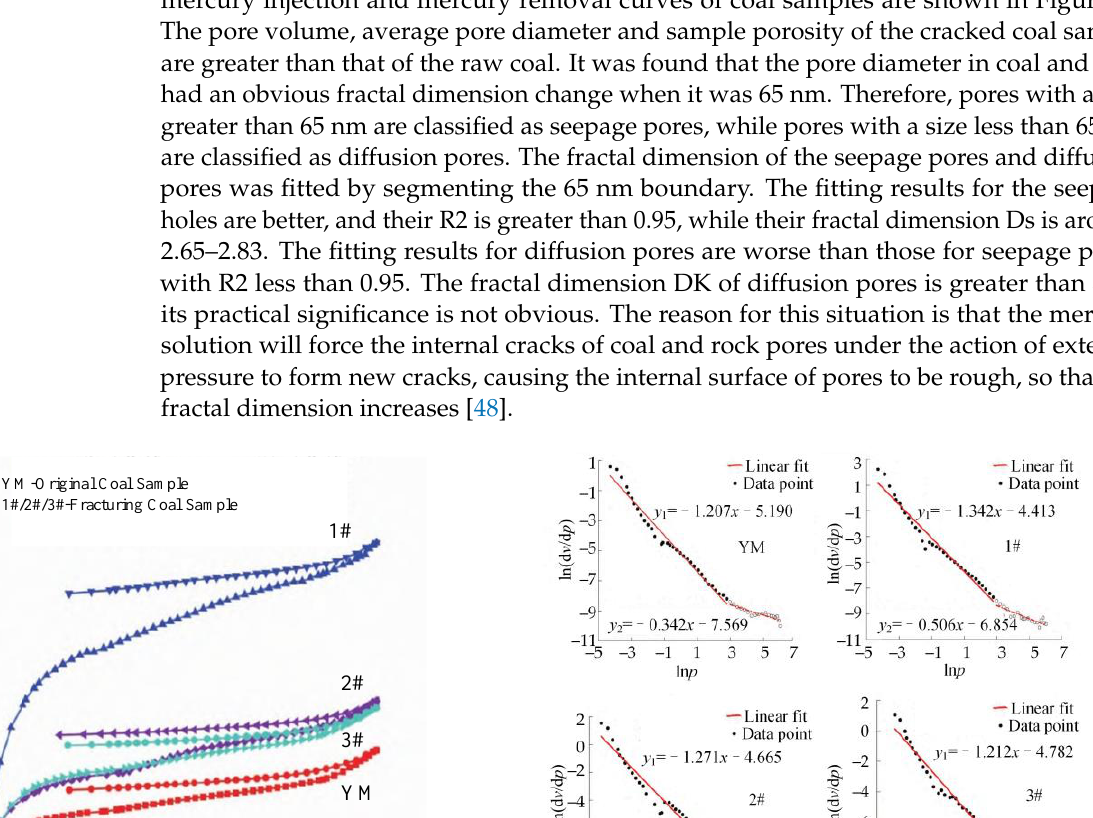
Figure 20. Box counting method for the calculation of DF [47].(a) Rriginal image, (b) Processed image, (c) Fractal box division, (d) Fractal curve fitting. A mercury injection test was carried out on coal samples before and after CDPTB.